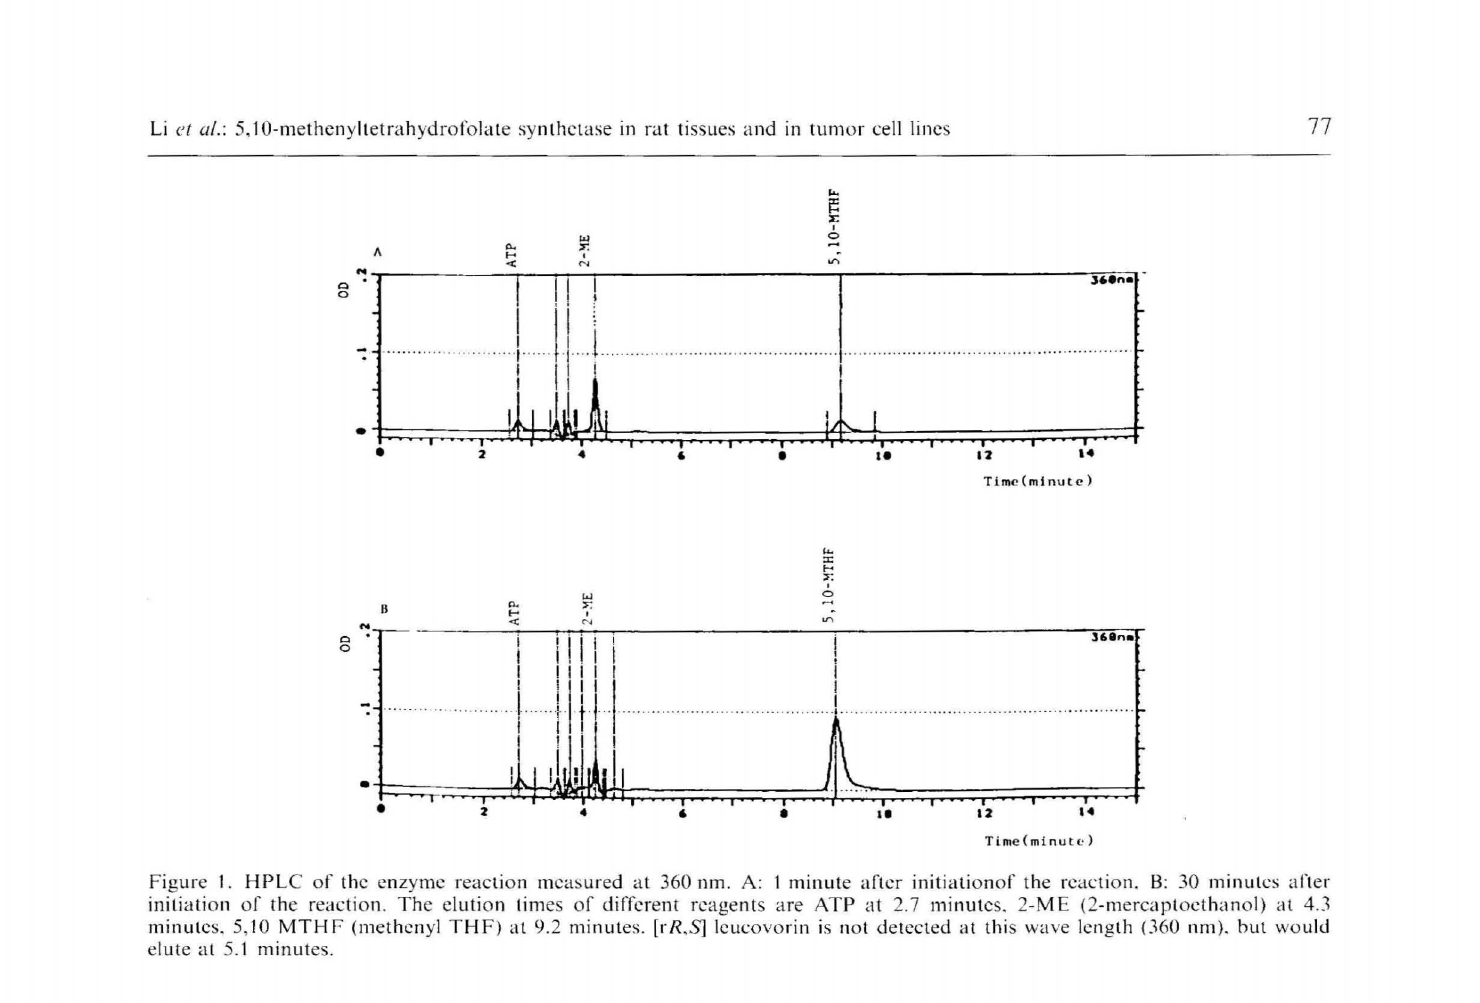
Table I. Tissue distribution of methenyl TH FS Tissue